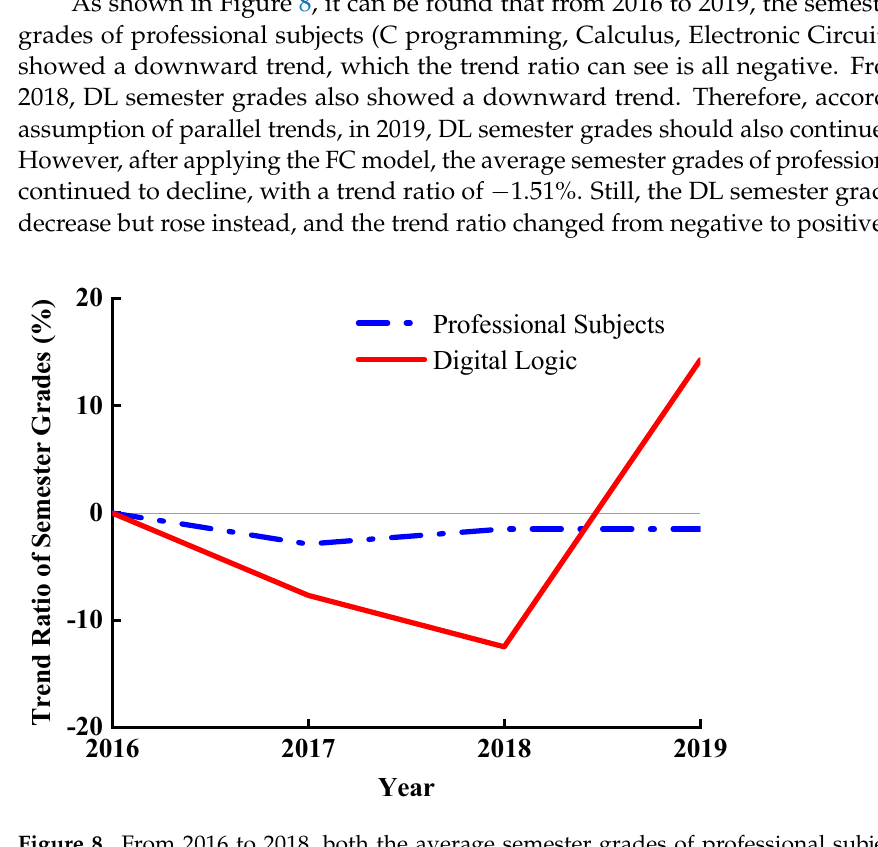
Figure 8. From 2016 to 2018, both the average semester grades of professional subjects and the DL semester grades have a downward trend (negative values). Therefore, in 2019, based on the assump- tion of parallel trends, the DL semester grades should also decline. However, due to the intervention of the FC model, the DL semester grades did not drop but